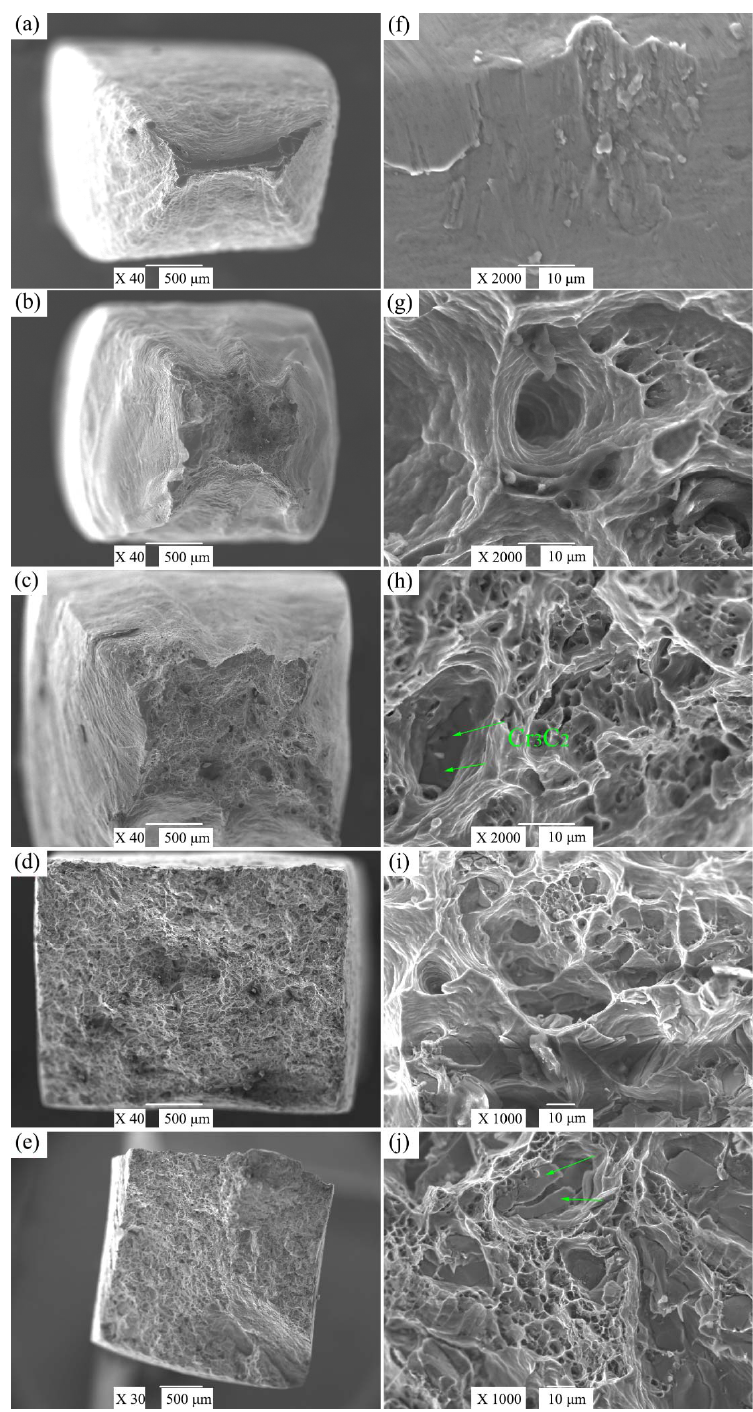
Figure 7. The fracture morphologies of the Cr 3 C 2 particle-reinforced Al matrix composite: ( a , f ) pure Al, ( b , g ) 1.0 wt. % Cr 3 C 2p /Al composite, ( c , h ) 2.0 wt. % Cr 3 C 2p /Al composite, ( d , i ) 3.0 wt. % Cr 3 C 2p /Al composite, and ( e , j ) 4.0 wt. % Cr 3 C 2p /Al